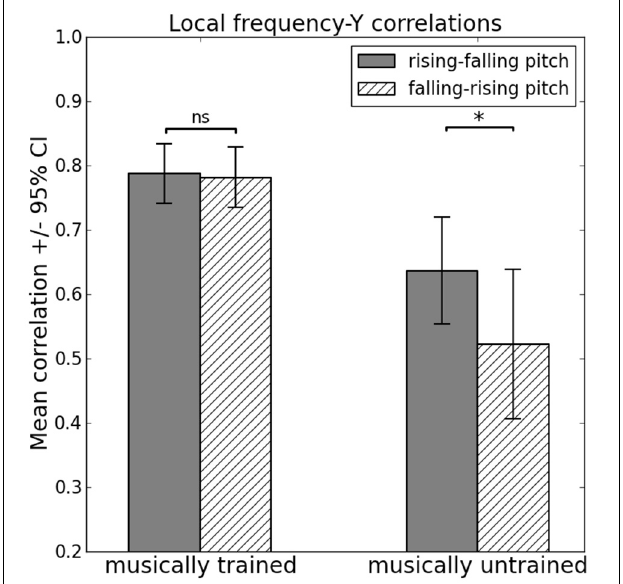
FIGURE 3 | Influence of interaction between musical training and pitch contour on local frequency–Y correlations. ∗ indicates p < 0 . 05, ns, not significant.